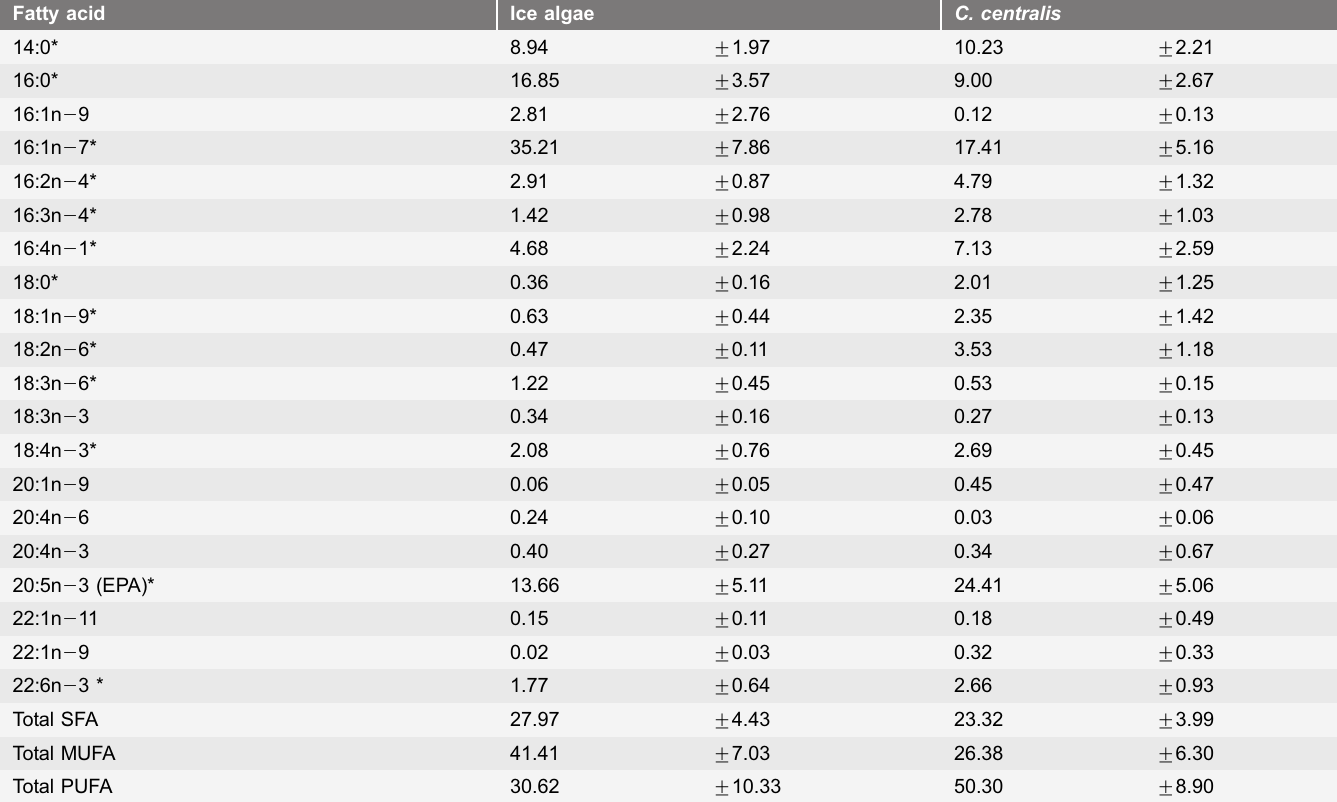
Table 1. Mean abundance ( ¡ SD) of selected fatty acids (expressed as mass % of total fatty acids) in ice algae and pelagic diatom Coscinodiscus centralis collected in spring